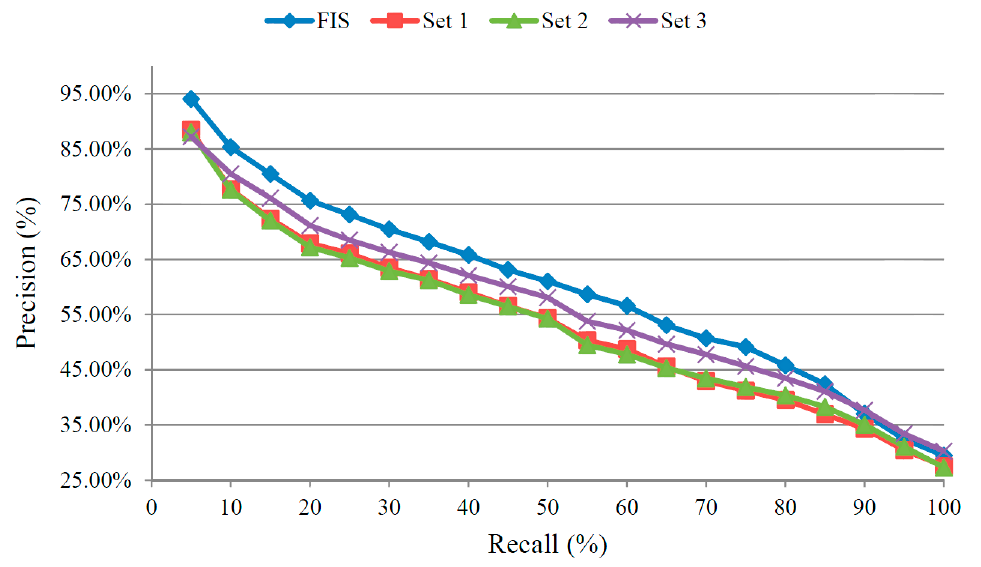
Figure 10. The comparison between the fuzzy inference system (FIS) and weighting assignment using precision and recall (P-R).